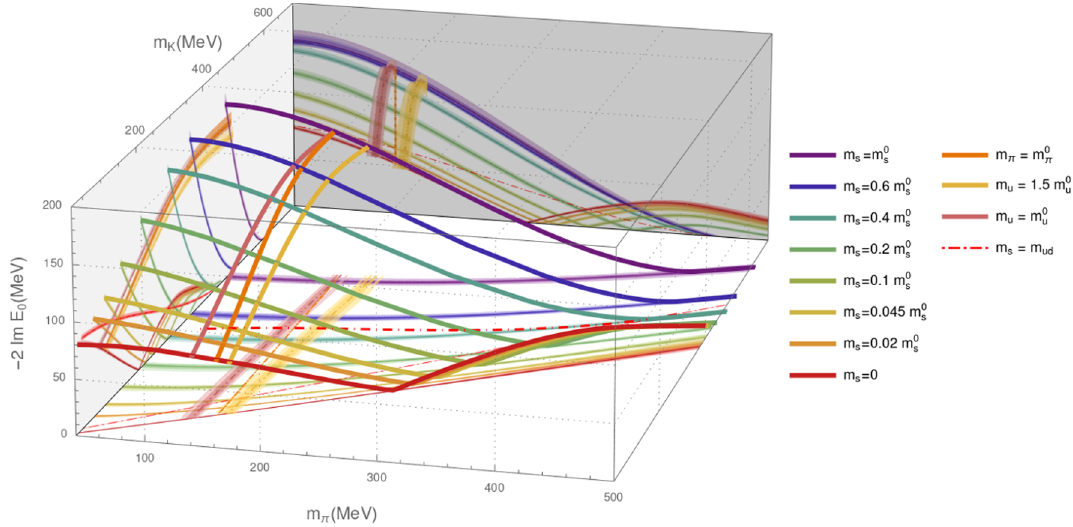
Figure 32 . The width of the (cid:26) -meson pole position, (cid:0) 2Im E 0 , as a function of m (cid:25) and m K for the